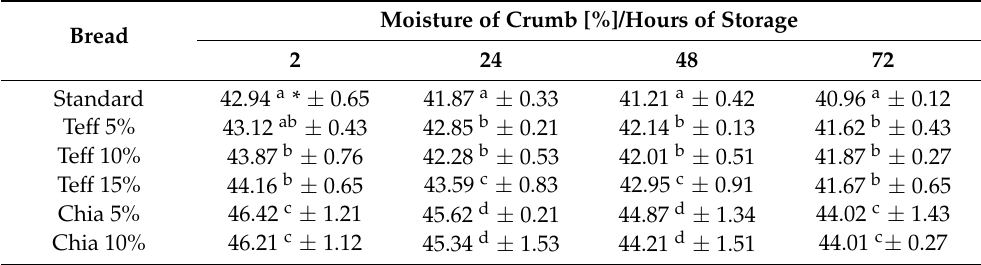
Table 4. Changes in the humidity of the crumb of the tested bread during storage.